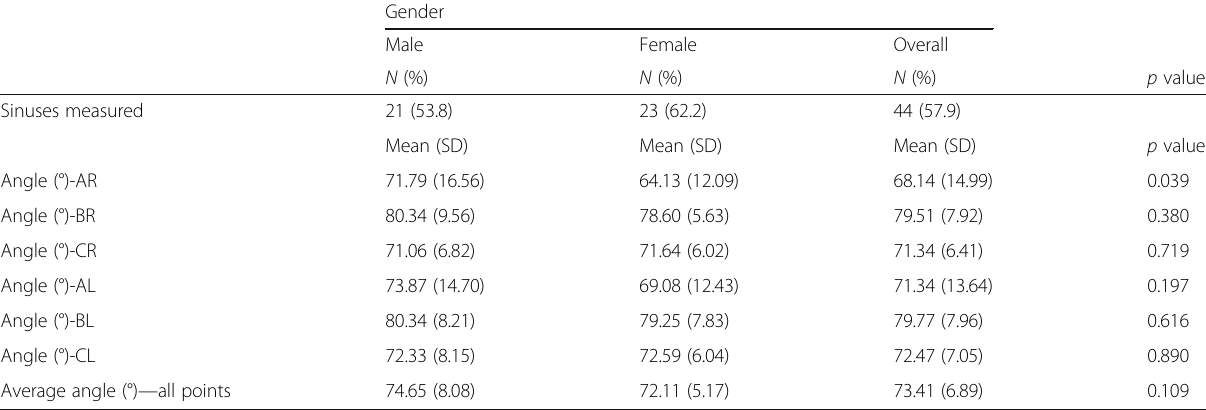
Table 4 Sinuses ’ angles by gender and overall